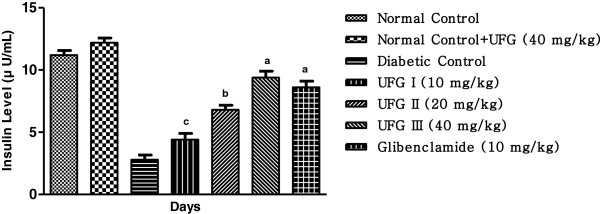
Effect of umbelliferone β-D-galactopyranoside on level of plasma insulin at different concentrations on STZ induced diabetic rats, compared to diabetic control group rats; values are mean ± SEM; n = 6;
c
P < 0.05;
b
P < 0.01;
a
P < 0.001; P > 0.05 is considered as non-significant (ns).